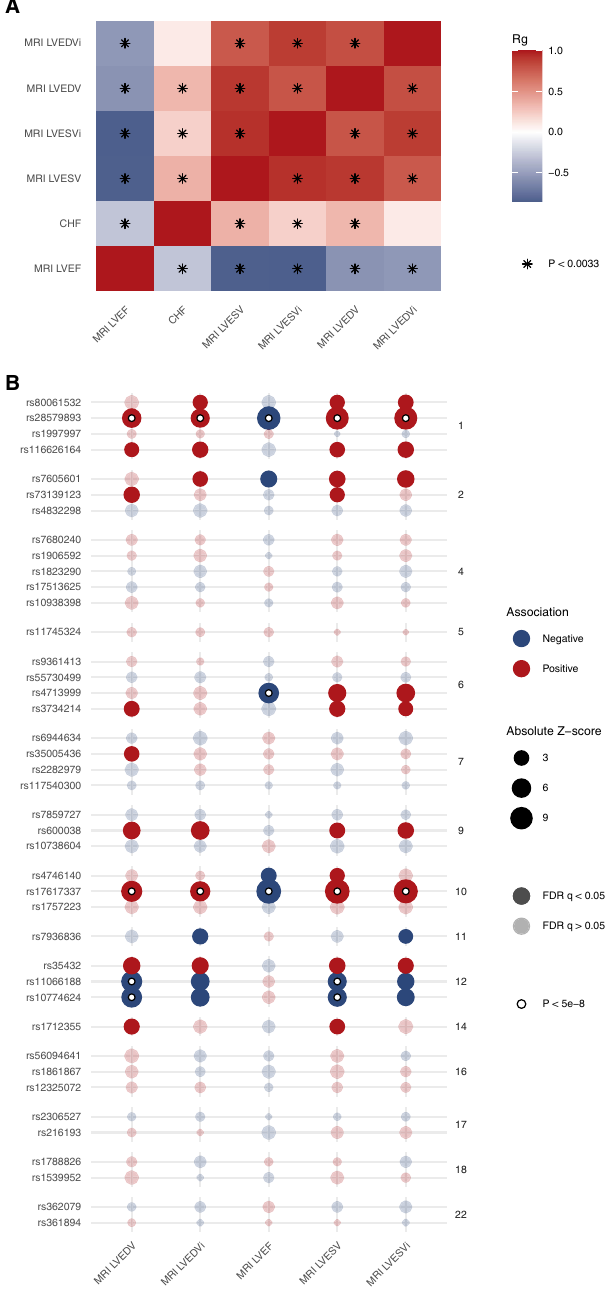
Fig. 4 | Shared associations between heart failure and cardiac MRI traits. A Cross-trait LD score regression was performed to estimate genetic correlations ( r g ) between heart failure and cardiac MRI traits. Signi fi cant associations using the Bonferroni method to account for multiple testing are noted with a star. B GWAS associationsbetweenleadheartfailureriskvariantsandcardiacMRItraits.Thesize ofeachpointdenotestheabsolutez-scoreforeachtrait,withreferencetotheheart failureincreasingallele.Theshadingofeachpointdenoteswhethertheassociation met an FDR adjustment for multiple testing. Associations exceeding the conven- tionalgenome-widesigni fi cancethresholdaredenotedwithawhitecircle.Variants are grouped by chromosome. LVEDV left-ventricularend-diastolic volume, LVEDVi left-ventricular end-diastolic volume indexed for body surface area, LVSEV left- ventricular end-systolic volume, LVESVi left-ventricular end-systolic volume indexed for body surface area, LVEF left-ventricular ejection fraction, FDR false discovery